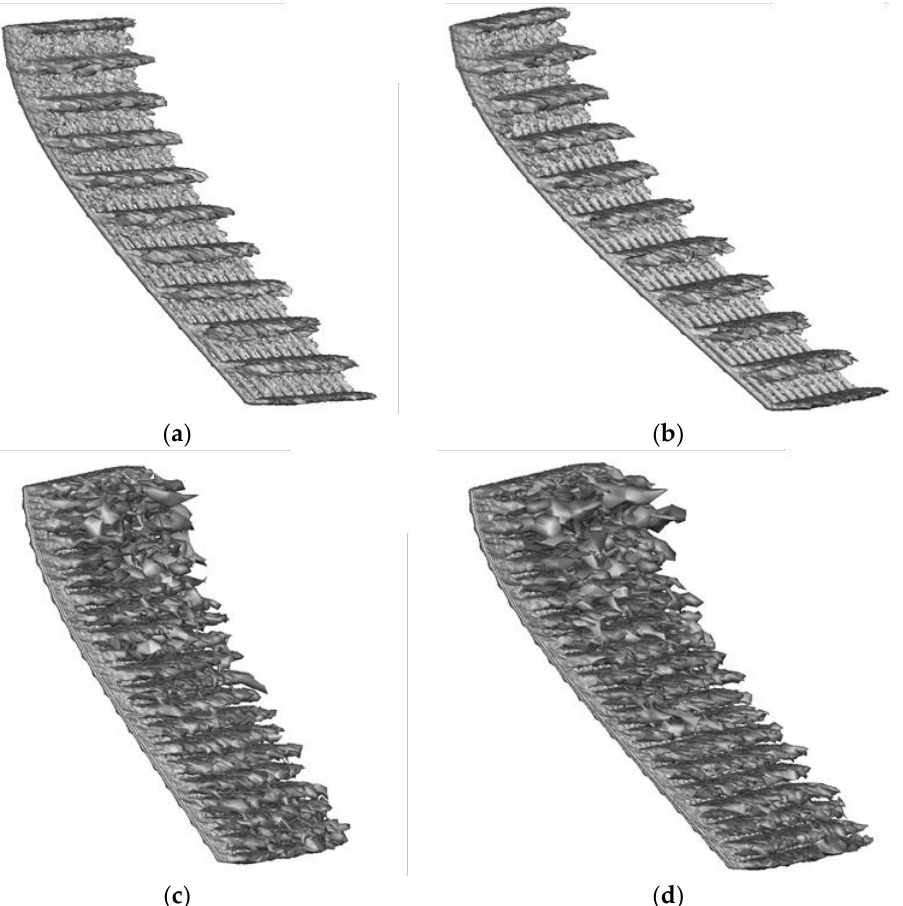
Figure 13. Three-dimensional instantaneous vorticity structures behind the flexible net panels at angles of attack between π/4 and π/3 : ( a , b ) 𝑆𝑛 = 0.16 ; ( c , d ) 𝑆𝑛 = 0.33 .